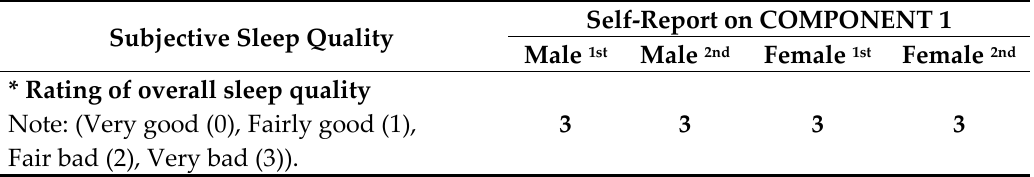
Table 1. Component 1 of the PSQI on the 4 flight attendants.